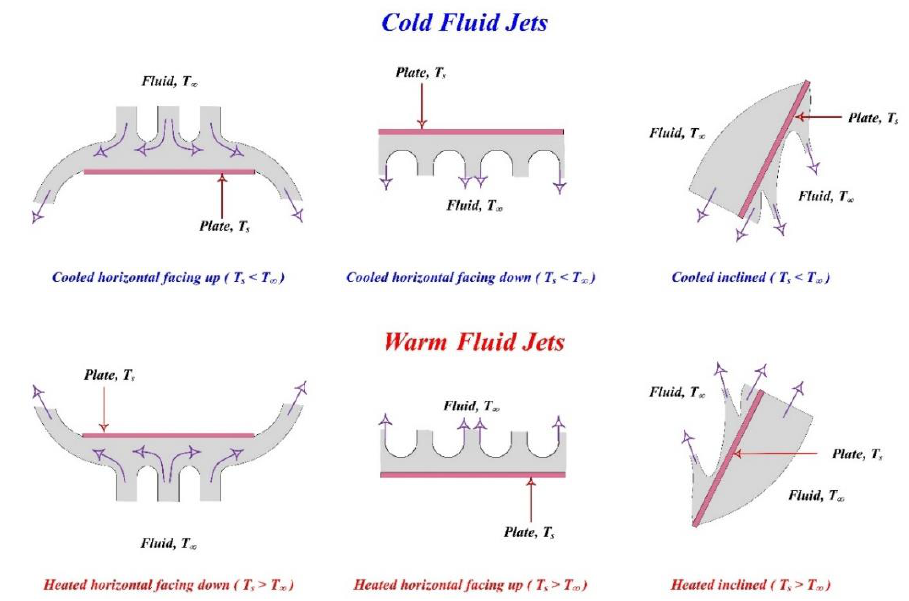
Figure 3. External convection flow on flat plate with different angles [2].